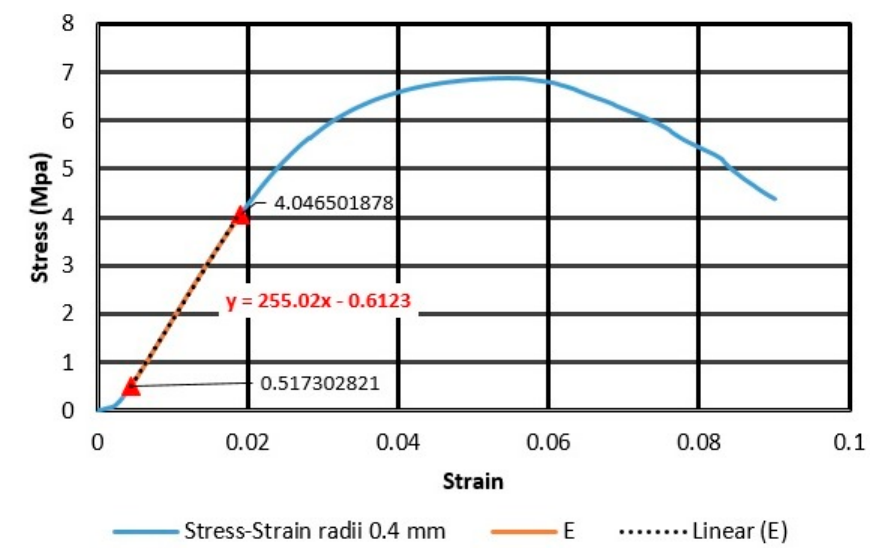
Figure 3. Stress–strain diagram and linear regression equations for the first specimen, with radius 0.4 mm.